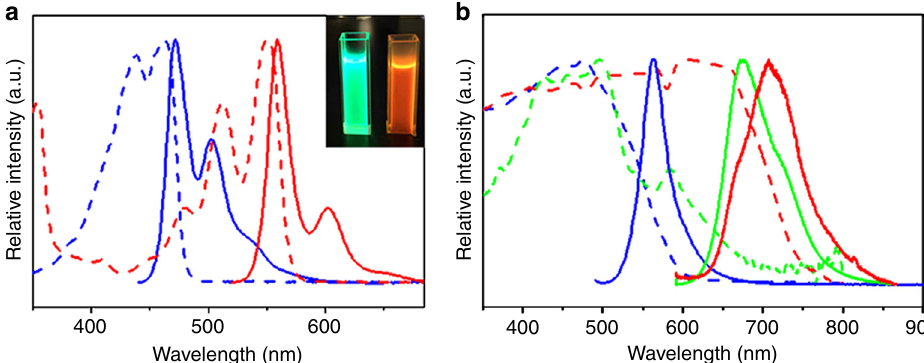
Fig. 6 Spectral characterization of BA, BN, and (BA) 0.72 (BN) 0.28 helical assemblies. a Normalized absorption and PL spectra of (blue curves) BA and (red curves) BN monomer solutions in THF. Inset shows the corresponding photographs when excited by 365 nm. b Normalized absorption and PL spectra of (blue curves) BA tubes, (green curves) (BA) 0.72 (BN) 0.28 helices, and (red curves) BN tubes